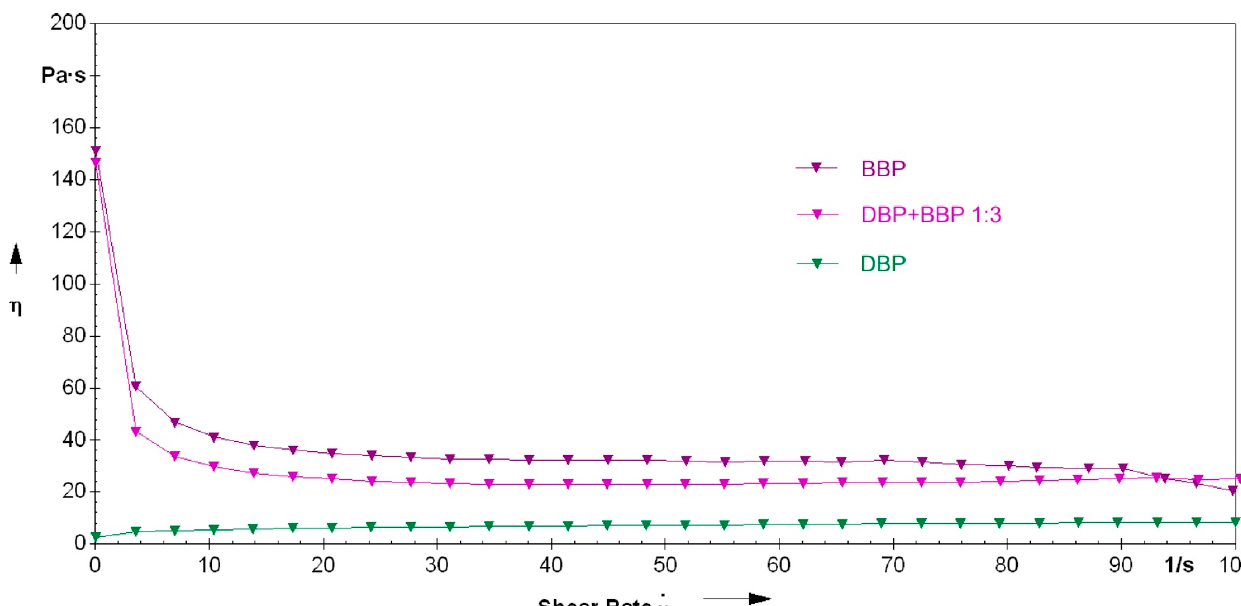
Materials 2021 , 14 , 1045 Figure 11. Direct comparison of the rheological properties of the formulations with either BBP, DBP, or a 3:1 mixture of the two.